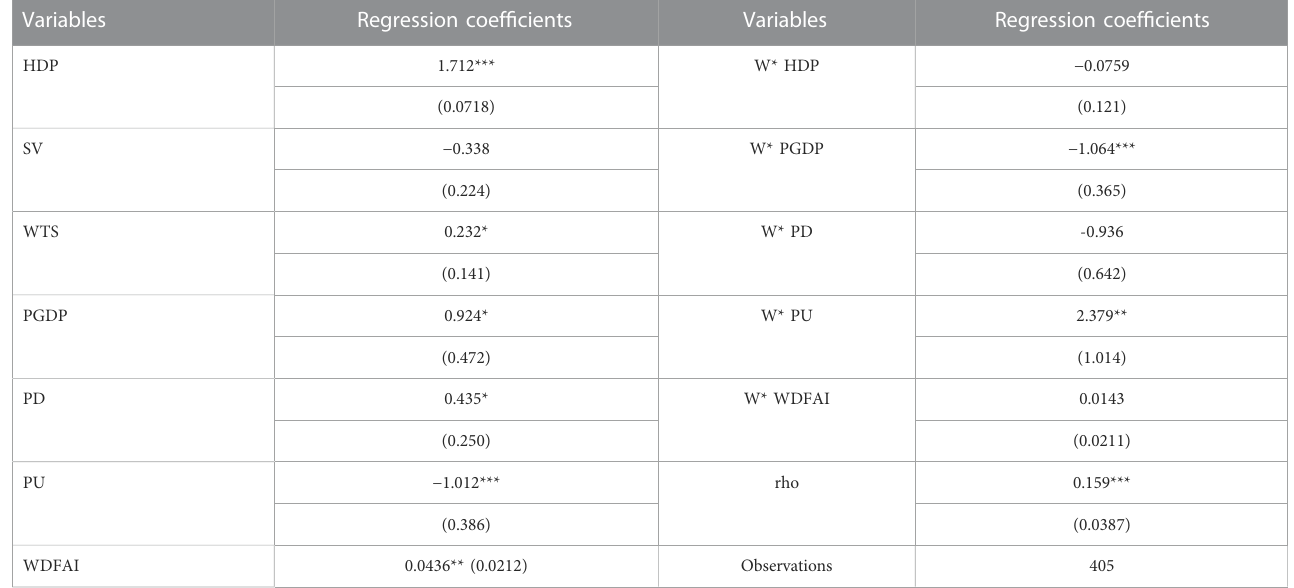
TABLE 5 The estimation results of spatial durbin model (SDM).